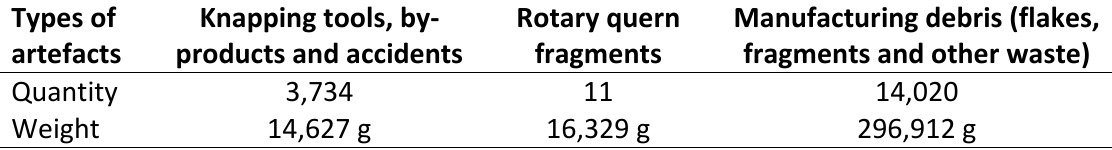
Table 2. Quantification of the types of artefacts collected in the rotary quern